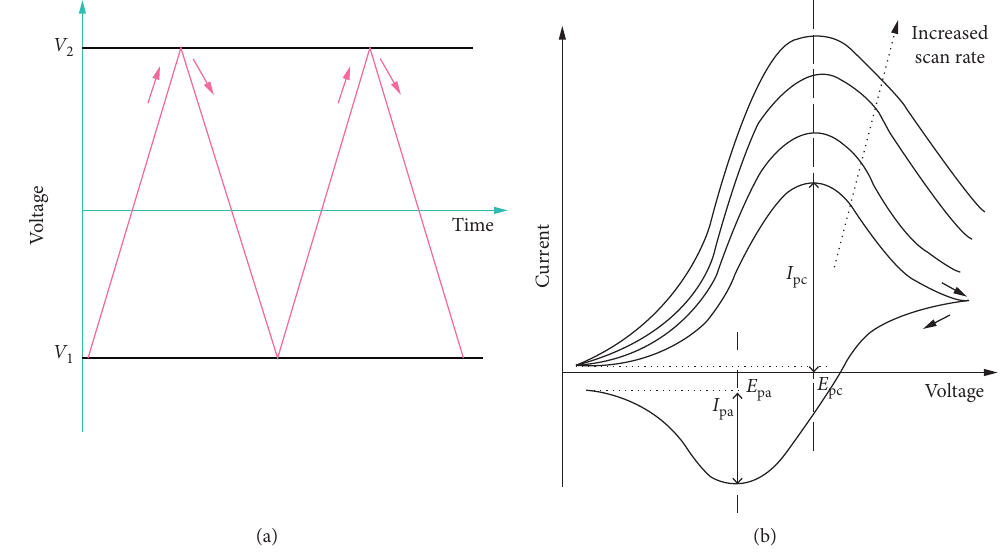
Figure 27: Representative (a) triangular wave form and (b) cyclic voltammogram as a function of scan rate